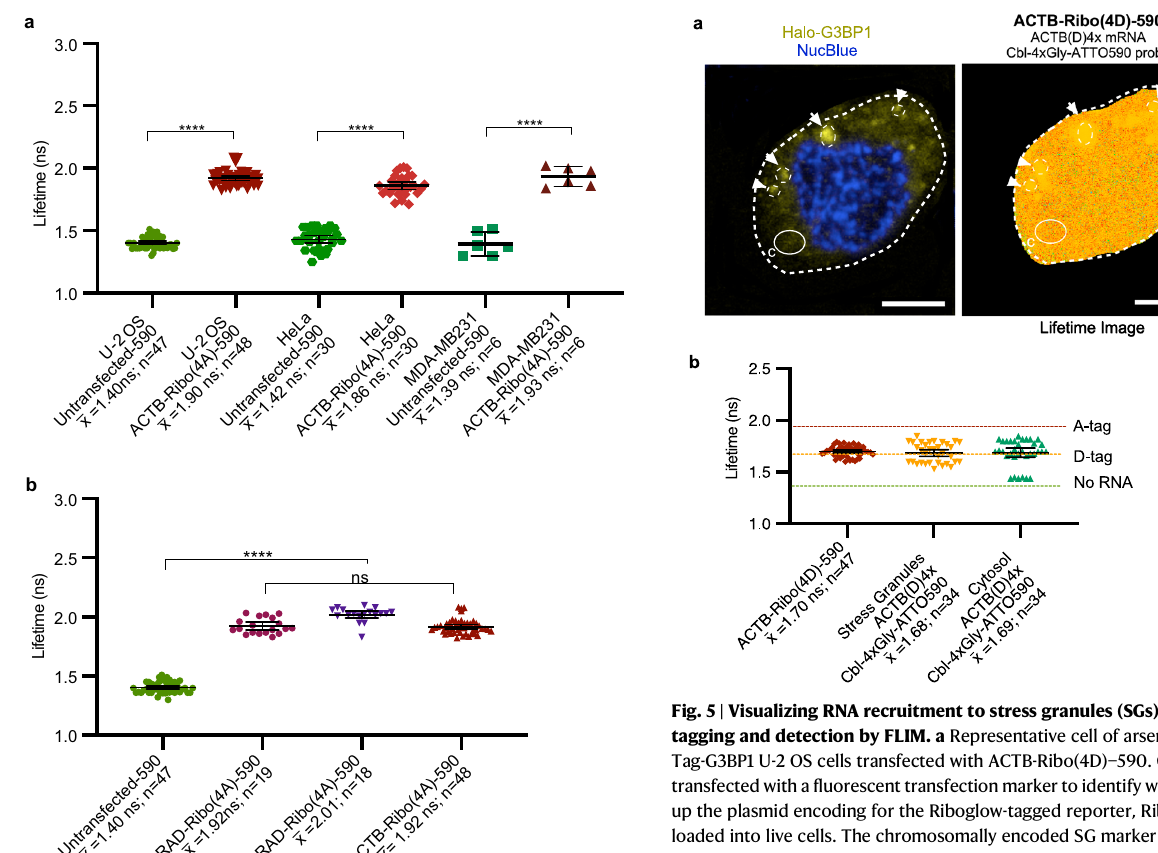
(Supplementary Table 1). The small RNA tag size (~100 nt) does not